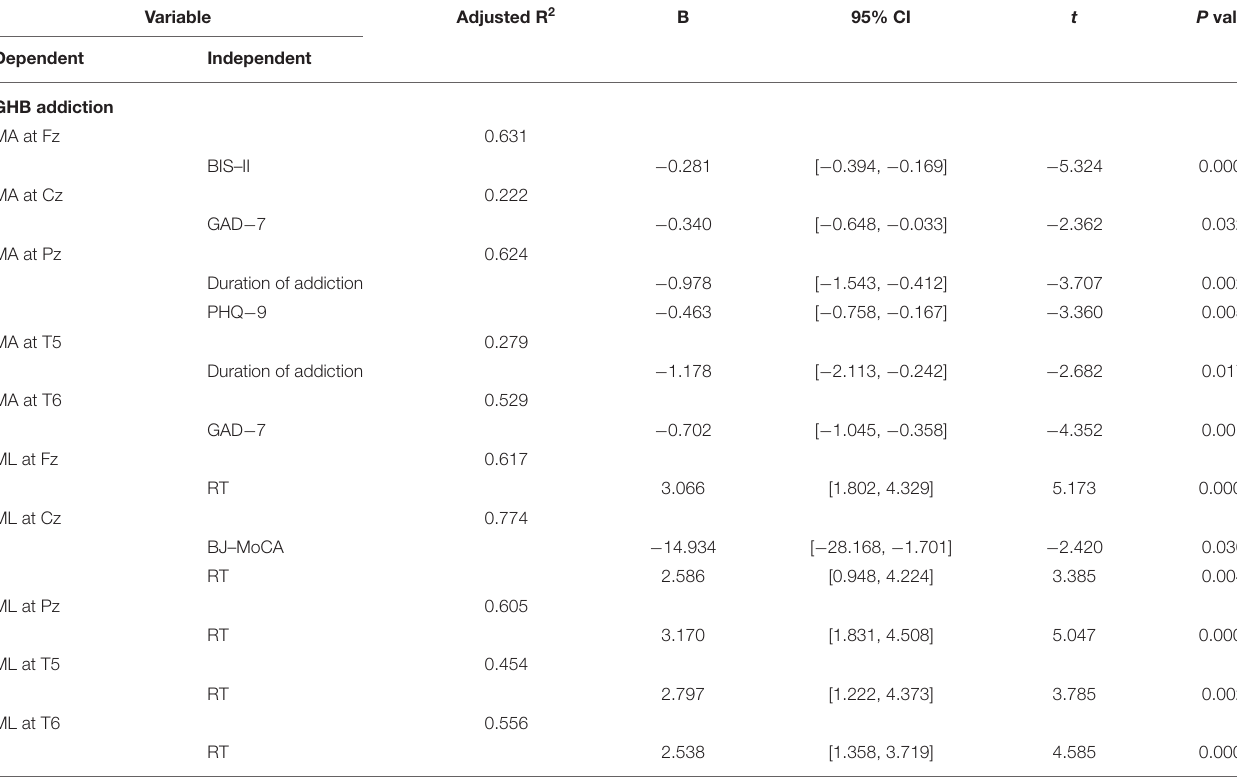
TABLE 2 | Stepwise regression model results for mean amplitude and mean latency of the GHB